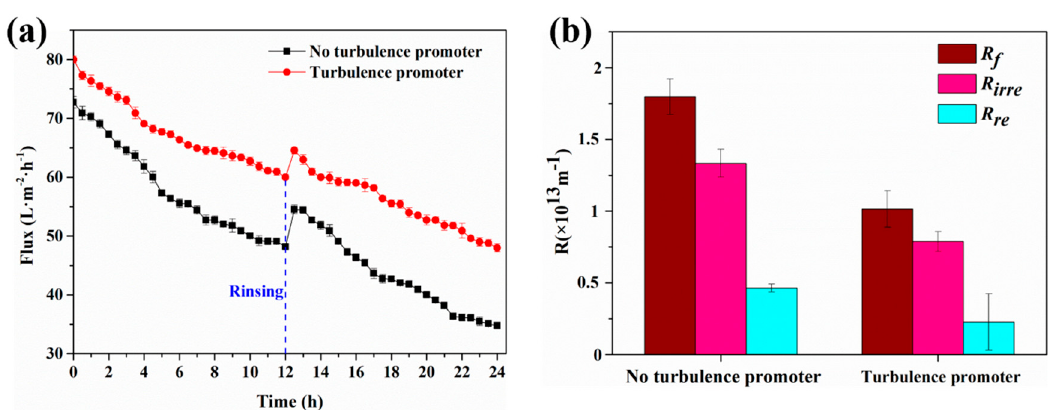
Figure 12. ( a ) Variations of flux with time and ( b ) effect of the turbulence promoter on membrane fouling resistance, irreversible membrane fouling resistance and reversible membrane fouling resistance (SSTS: 500 ppm HA, pH = 4; TMP = 0.5 MPa).